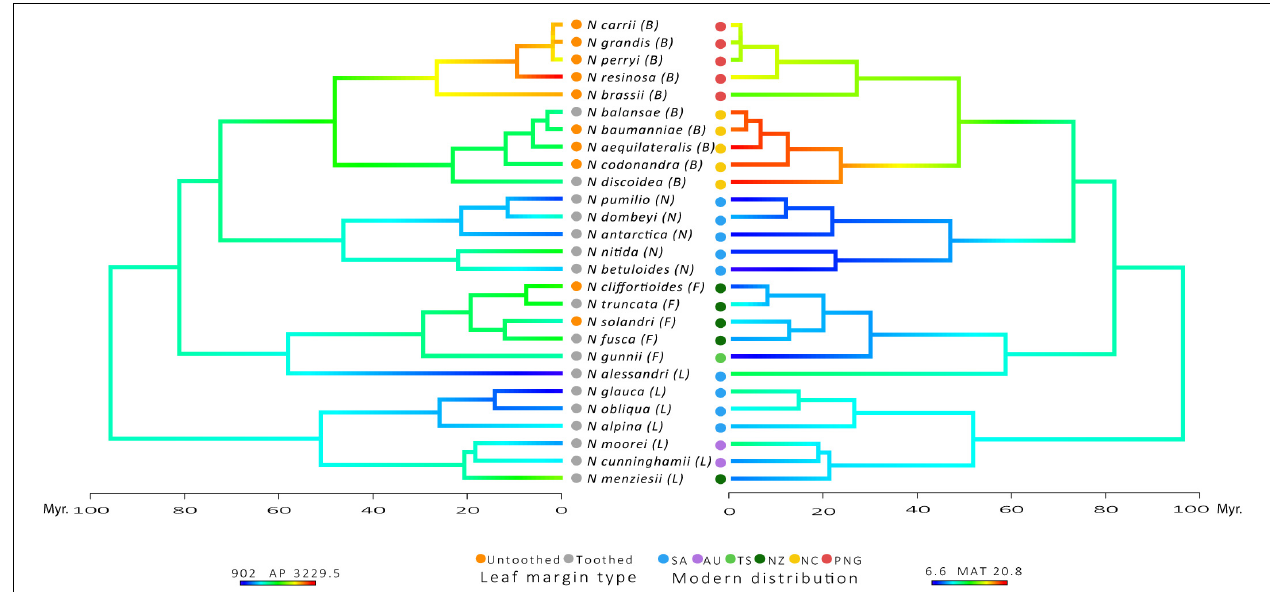
FIGURE 2 | Plot of Leaf margin type character at the tips of the phylogenetic tree along with reconstruction states onto internal edges and nodes of AP and MAT. Modern distribution: SA, South America; AU, Australia; TS, Tasmania; NZ, New Zealand; NC, New Caledonia; PNG, Papua-New Guinea. Subgenera: L, Lophozonia ; F, Fuscospora ; N, Nothofagus ; B, Brassospora . Time scale of divergence for Nothofagaceae species.